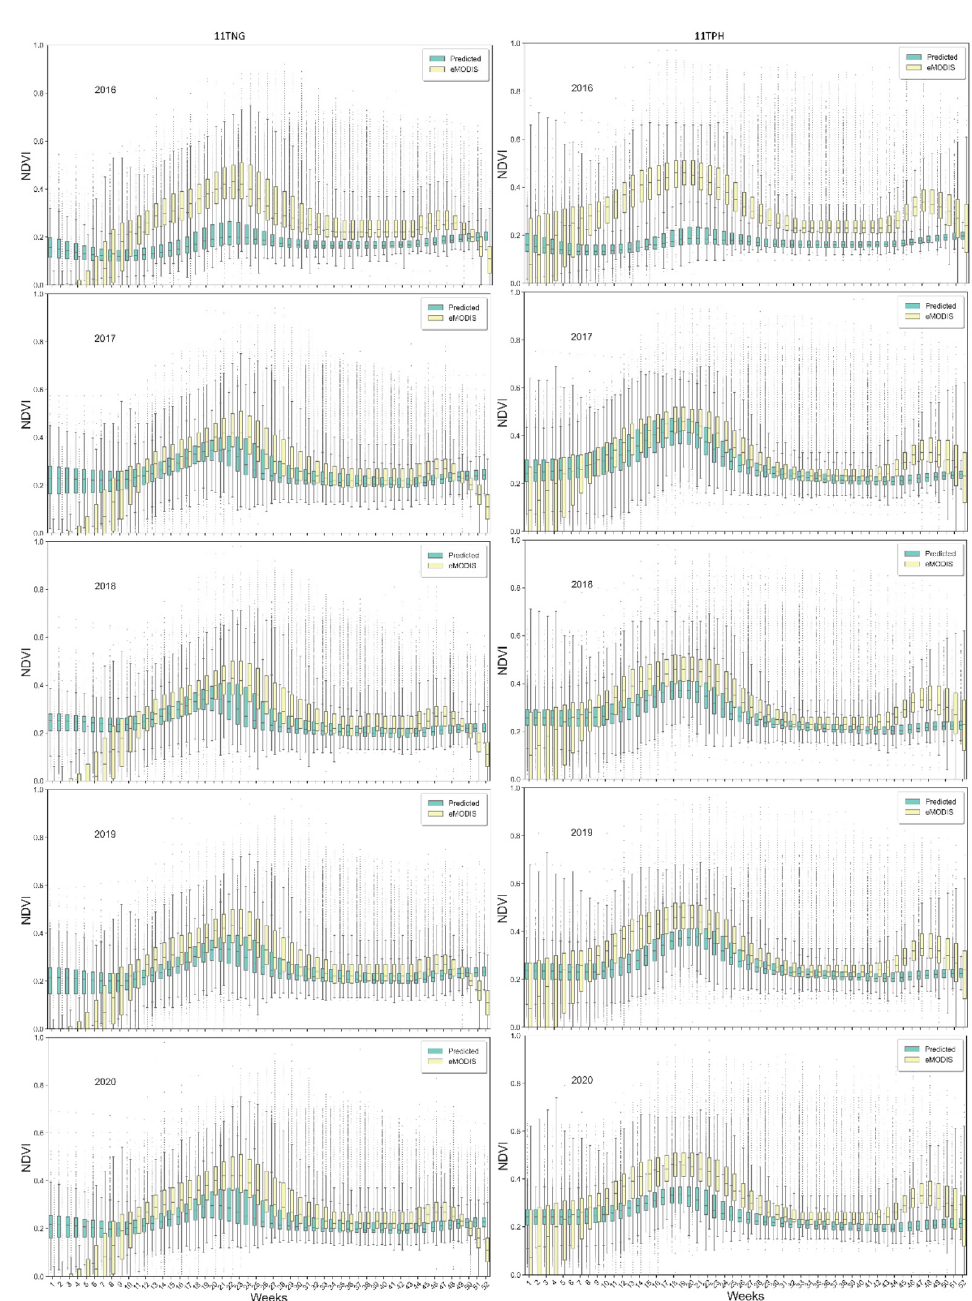
Figure A1. Box and whisker plots, as an example for tiles 11TNG and 11TPH, showing weekly time- series model predicted NDVI (NDVI PRD ) and eMODIS NDVI for all mapped years and weeks. Boxes represent the 25th and 75th percentile, while horiizontal lines inside the boxes indicate median values. The whiskers extend to a range of values that are within the median ± 1.5 times the interquartile